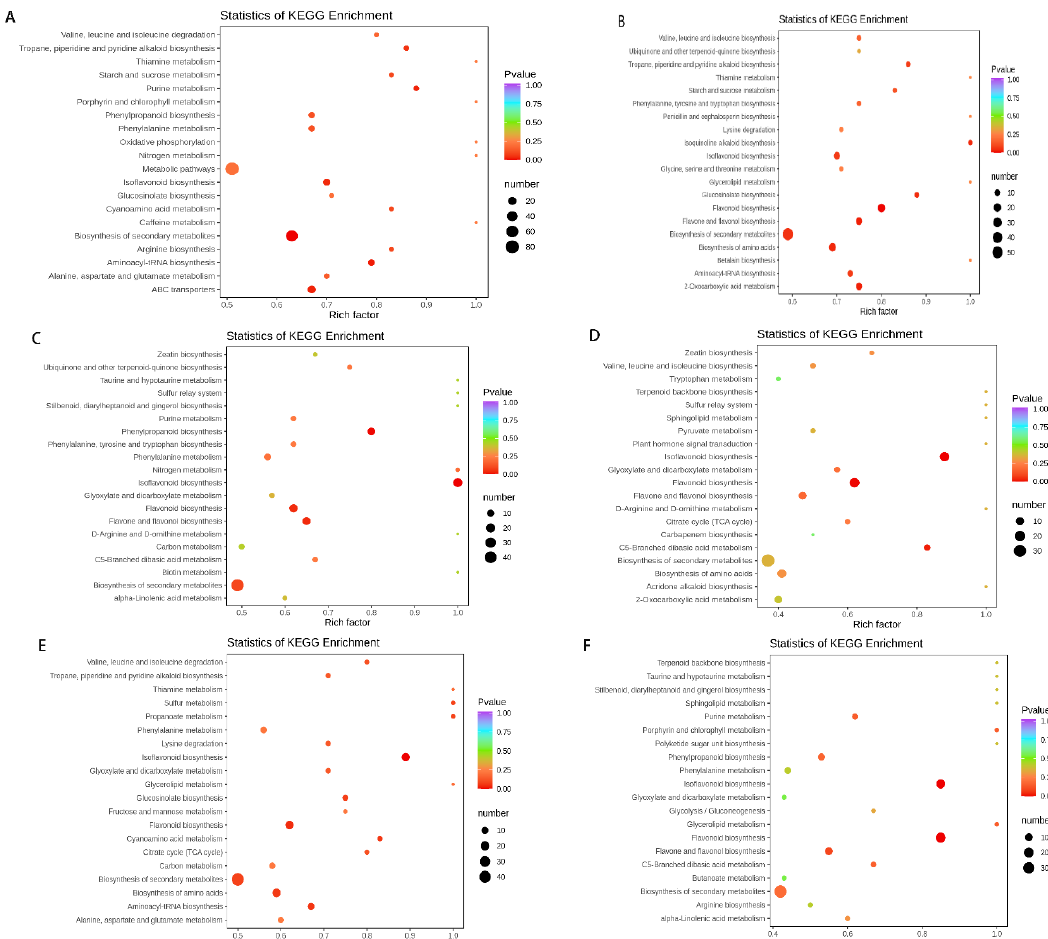
Figure 8. KEGG enrichment map of differential metabolites among the comparison groups ( A – F ), including JG vs. CK; JG vs. YS; QS vs. CK; QS vs. YS; JG vs. QS; and CK vs. YS. The abscissae represent the rich factor corresponding to each pathway. The higher the value, the higher the enrichment degree. The ordinates represent different metabolic pathways. The colour of the dot stands for the p -value; the redder the dot, the more significant the enrichment. The size of the dots represents the number of differential metabolites enriched in a given metabolic